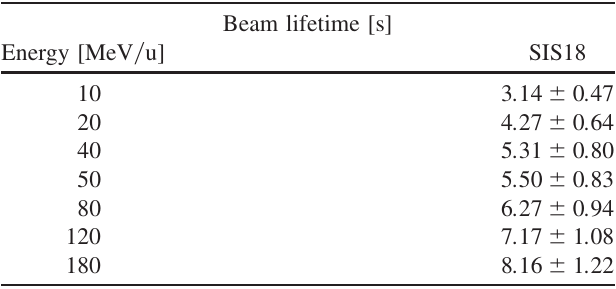
TABLE I. Measured lifetimes of U 28 þ beams at various ener- gies in the SIS18 synchrotron. The errors account for a system- atic uncertainty due to the low precision of the beam current transformer at low beam intensities.